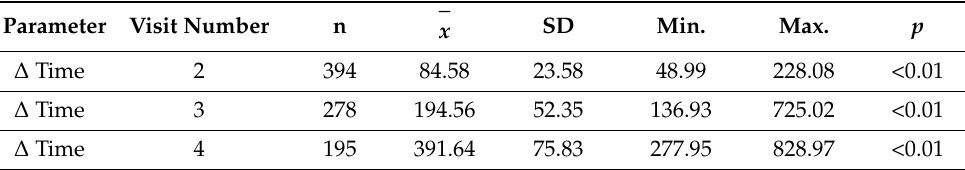
Table 3. Variables of time of consecutive specialized